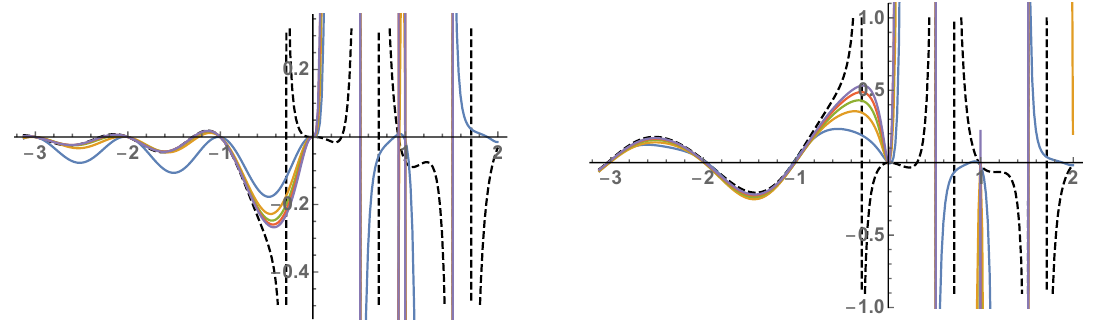
(cid:5) Figure 6 . In black, dashed: the transform f ( α, α + j ) for the function given in equation (4.46) as a function of α with j = 0 (left) and j = 6 (right). We have divided by a normalization factor Q ( α )Γ( ± ( α + j ))4 − α − j which in particular got rid of all the kinematic poles. Colored lines: the approximation to this density by transforming a finite sum of the first few t -channel blocks, ranging from a single block (blue line) to 45 blocks (purple line). As expected, we observe good convergence for negative α . Since we chose ∆ φ = 0 . 7 the individual t -channel blocks only produce poles at α = 0 . 2 and so we can only approximately observe the actual pole at α = − 0 . 3